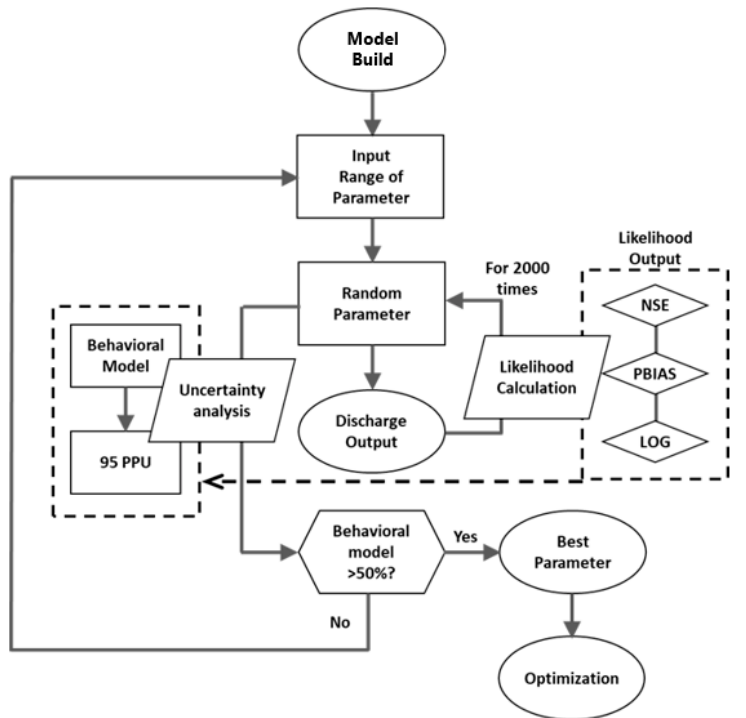
Figure 6. GRM uncertainty analysis algorithm .